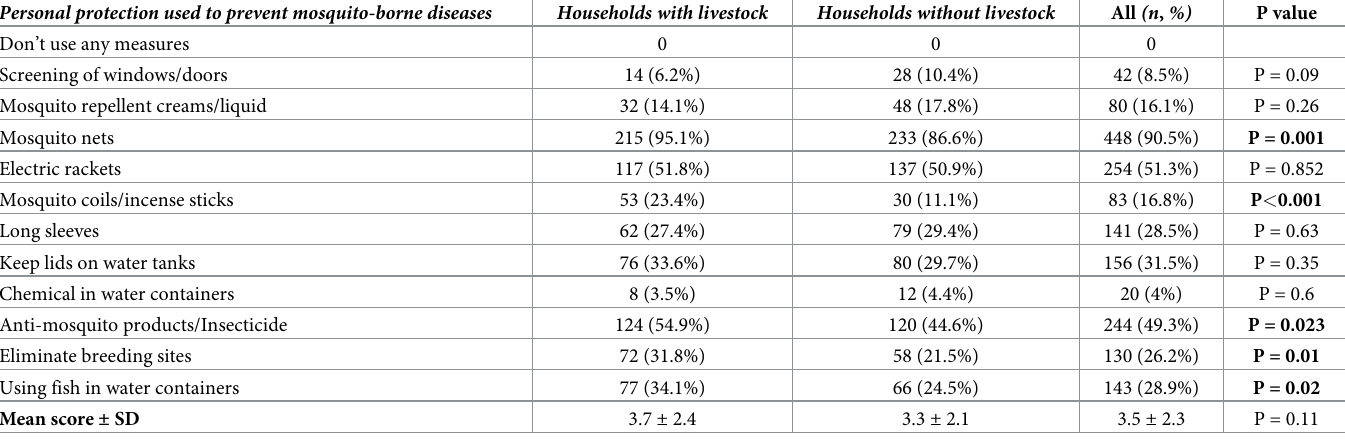
Table 3. Participants’ practice on prevention against MBDs in households with and without livestock in Hanoi, Vietnam. Personal protection used to prevent mosquito-borne diseases Households with livestock Households without